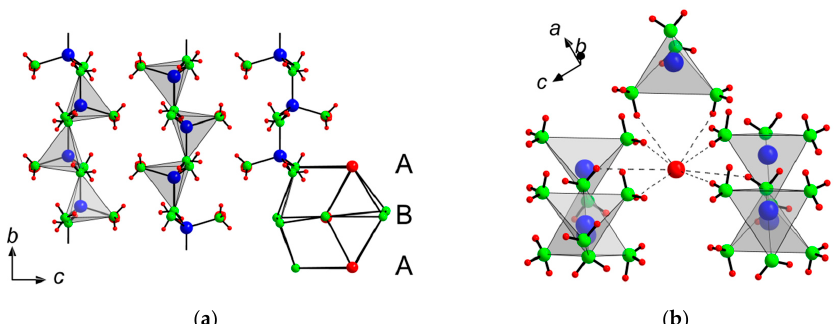
(cid:104) + (cid:105) ( NH ) Zn ( NH 3 ) 2 2 2/2